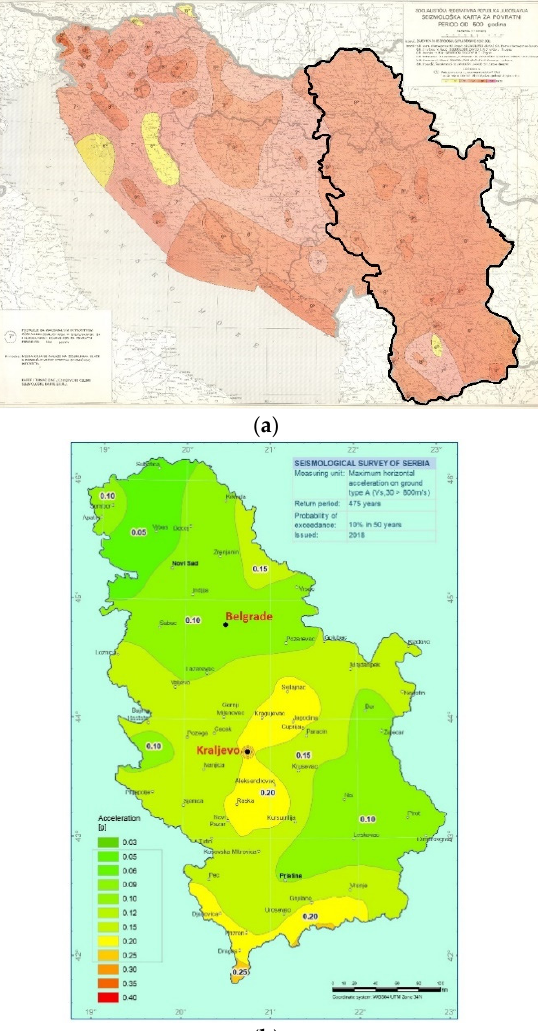
Figure 3. Seismic hazard maps: ( a ) seismic intensity map for SFRY (including Serbia) according to the MCS-64 scale published in 1987 for the 500-year return period earthquake (in compliance with the PTN-S code) and ( b ) seismic hazard map for Serbia showing the design PGA values for an earthquake with 10% probability of exceedance in 50 years, according to Eurocode 8, Part 1 (EC8-1).